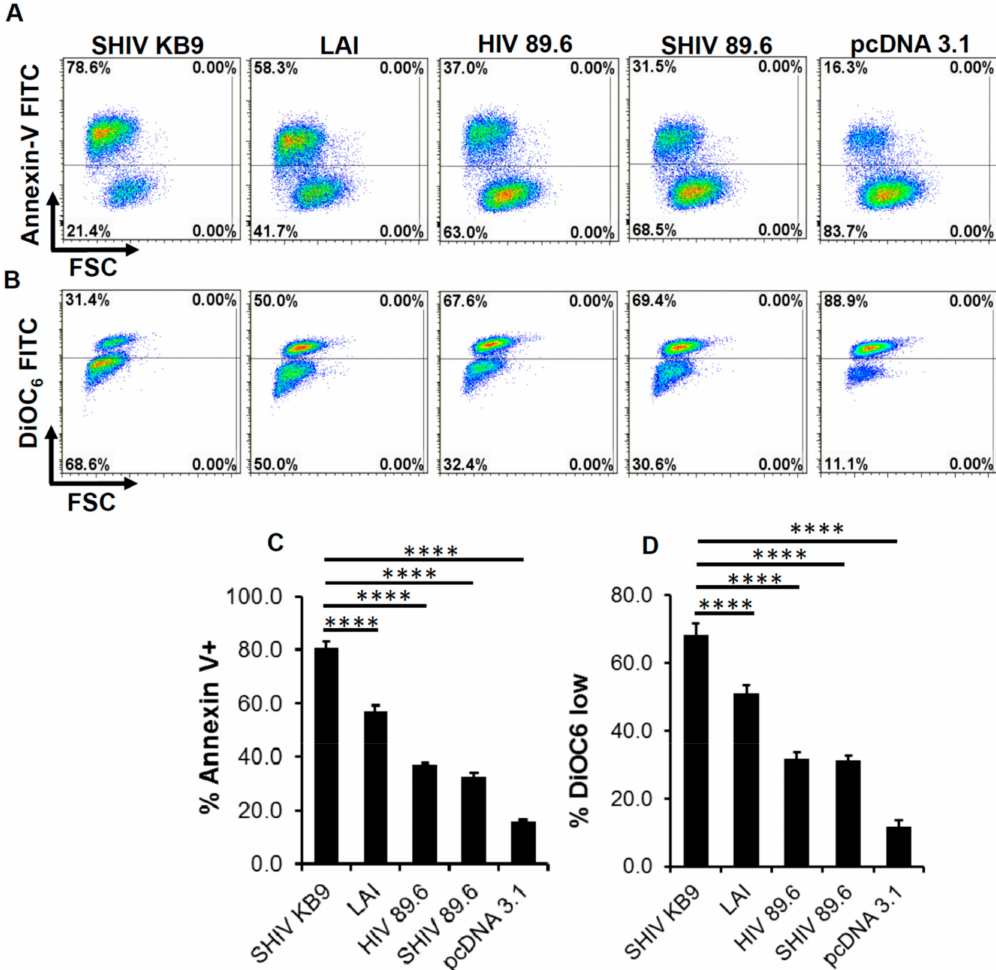
Figure 1. SHIV KB9 Env mediates higher apoptosis in bystander CD4 + T cells. HeLa cells were transfected with pSHIV-Env (KB-9 or 89.6), pHIV-1-Env (89.6 or Lai) or control vector pcDNA3.1 and co-cultured with the SupT1 cell line. Apoptosis was detected either via annexin V staining or DiOC6 staining 24 hours post co-culture. Representative dot plots for annexin V ( A ) and DiOC6 staining ( B ) are shown. Apoptosis induction by di ff erent Envs as determined by Annexin V ( C ) or DiOC6 staining ( D ) is shown. Data are mean ± SD of triplicate observations. p ≤ 0.0001 as determined by one-way ANOVA followed by Dunnett’s multiple comparison test. All experiments were repeated with similar